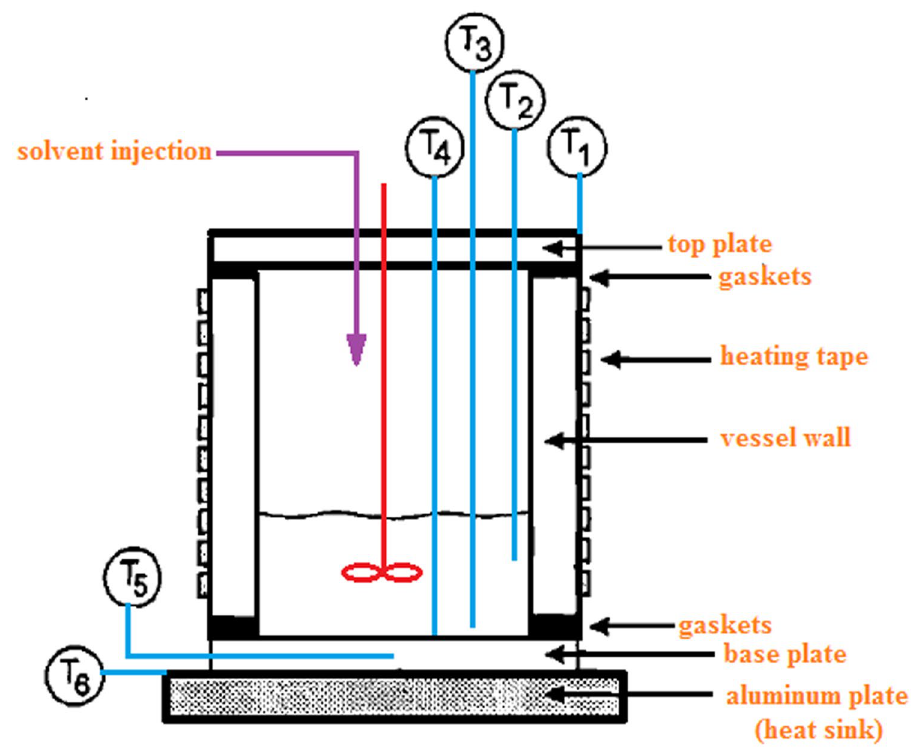
Fig. 18 Schematic of heat trans-